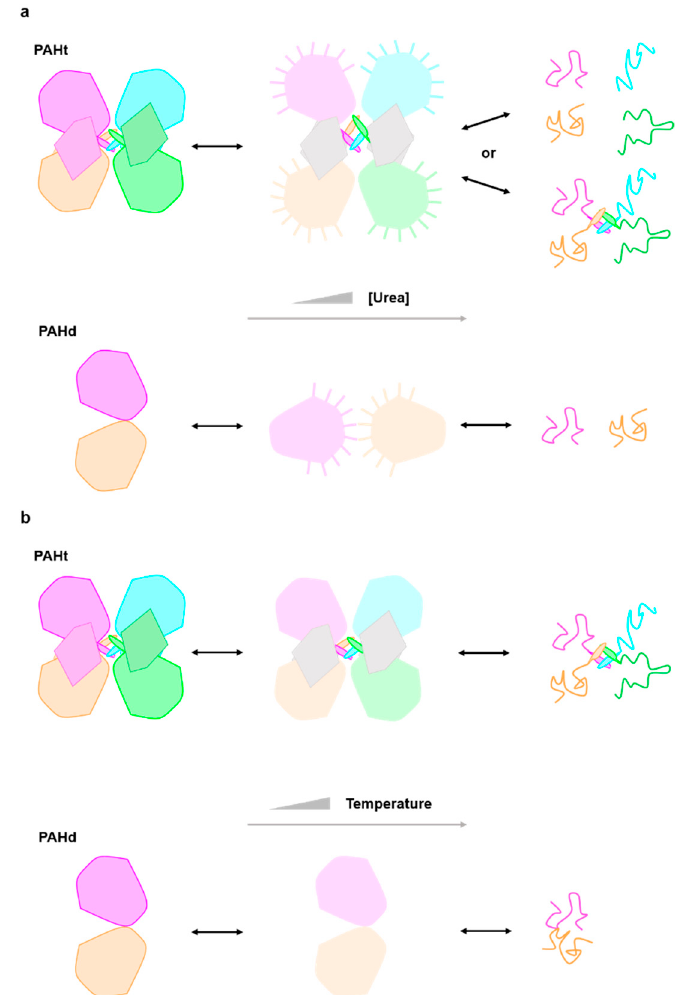
Figure 4. Structural cartoon describing the PAH three-state ( a ) chemical (urea) and ( b ) thermal unfolding equilibrium. Each subunit in PAHt is differently colored (dark pink, blue, orange and green) representing the four monomers in PAHt. Within each subunit, the large globule represents the catalytic domain and the small irregular pentagon the regulatory domain. The tetramerization helix of each monomer is also represented. The two subunits in PAHd (colored in dark pink and orange) are also represented by globules, as they consist essentially of the catalytic domain (see Figure 1). In the chemical unfolding driven by urea ( a ) the catalytic domains partly unfold (light color large globules) and remain in compact conformations where the tryptophan residues are not fully exposed to solvent. No information is available relative to the conformation of the regulatory domains (small irregular pentagons depicted in grey) in the intermediate. The interactions between pairs of catalytic domains in PAHt may be lost, but they can establish unspecific interactions with the same domains in other PAHt molecules, which is represented by lines pointing out from the potentially sticky surfaces in the partly unfolded catalytic domains. In the second step, the catalytic (and probably also the regulatory domains) unfold. The monomers may or may not dissociate. With the same color code, the urea unfolding equilibrium of PAHd is represented in the lower line. In PAHd, the two monomers dissociate in the intermediate, but their conformation appears to be compact, as judged by fluorescence data, and they seem to establish non-native interactions with additional monomers which are broken in the second step leading to the fully unfolded state. During thermal unfolding ( b ) the catalytic domains partly unfold but remain associated. No information is available relative to the conformation of the regulatory domains in the intermediate. In the second step, the catalytic (and probably also the regulatory domains) unfold. The monomers remain associated. The thermal unfolding equilibrium of PAHd is represented in the lower line. In PAHd, the two partly unfolded monomers remain associated in the intermediate and also in the fully unfolded